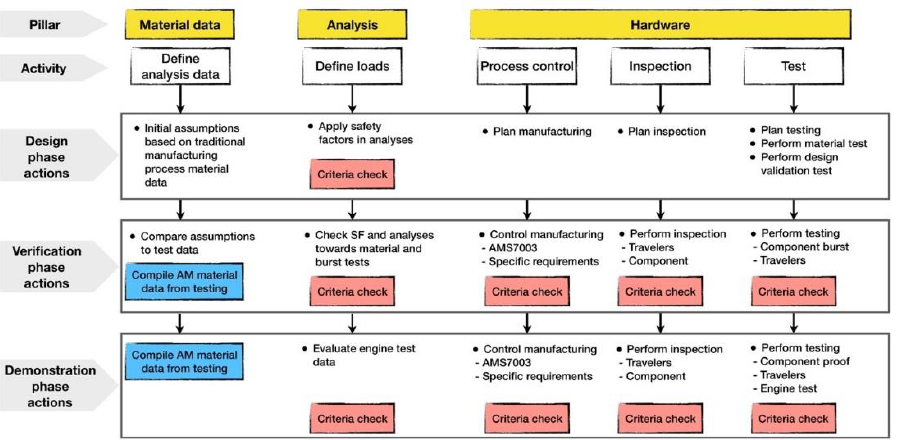
Figure 5. Pillars of the verification approach for the AM turbine (courtesy of GKN Aerospace).